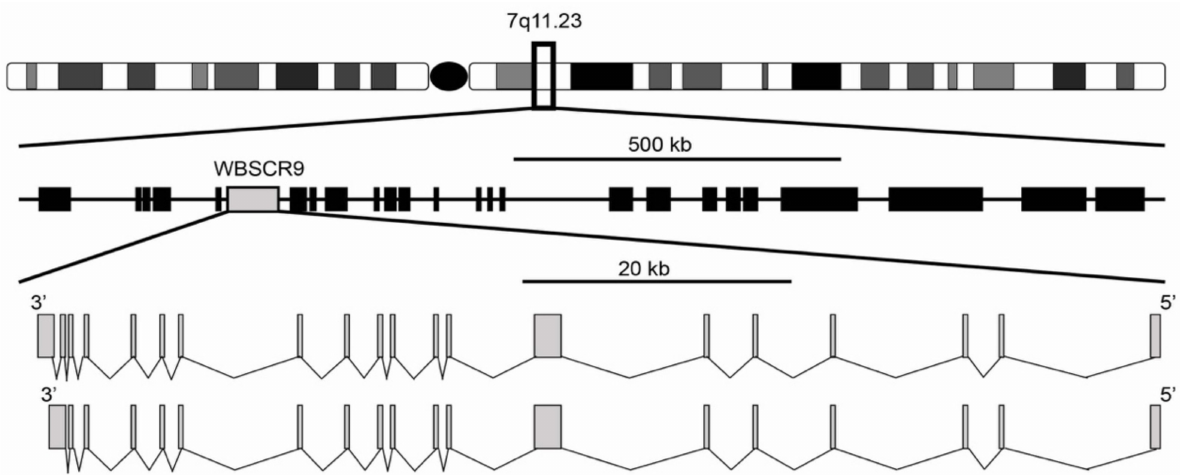
Figure 1. Genomic organization of WS deletion region including WBSCR9 gene. There are two isoforms of BAZ1B gene on DNA minus strand with either 19 or 20 exons.